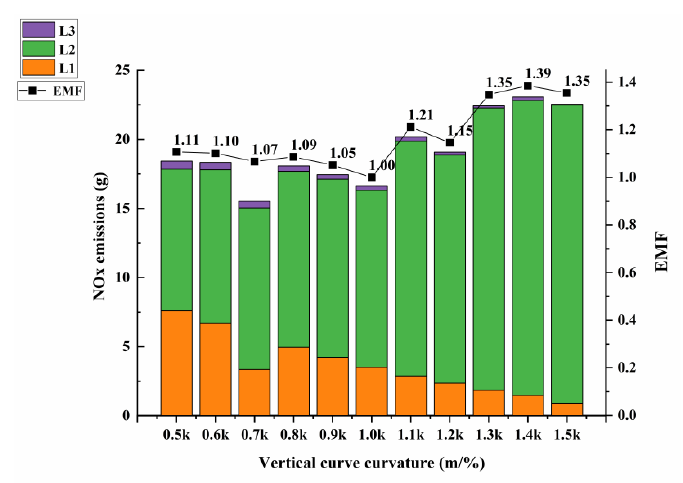
Figure 5. Relationship between NO x emissions and curvature.